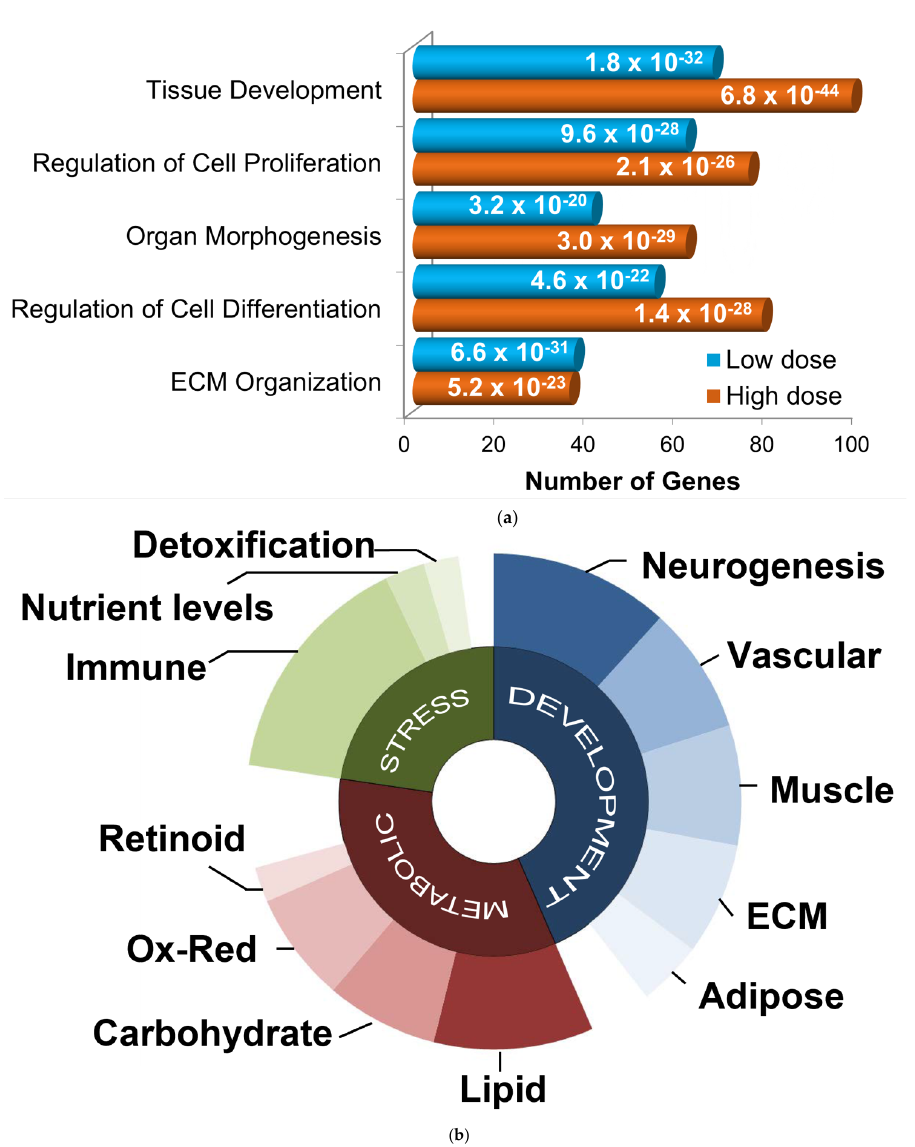
Figure 3. Functional categorization of GGF2-altered genes. ( a ) Bar chart showing functions enriched in differentially expressed gene lists from GGF-2 treated versus untreated LV tissues, identified using Ingenuity Pathway Analysis software. Functions are listed on the y -axis, and the x -axis indicates the number of differentially expressed genes in each category. Teal and orange represent low and high doses of GGF2, respectively. Enrichment p -value is indicated on each bar. ( b ) Pie chart showing top gene ontology categories for GGF-2 altered genes manually grouped into three generalized associative categories: development ( blue ), metabolic ( red ), and stress response ( green ). Uncharacterized and poorly characterized transcripts were